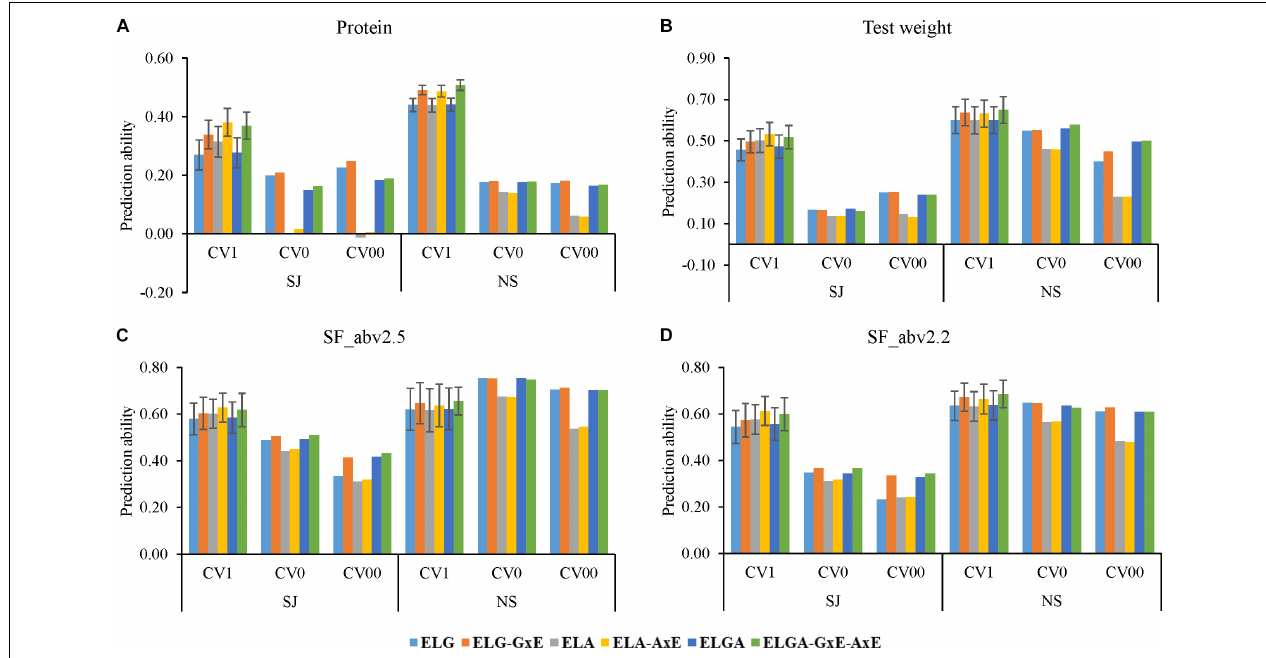
FIGURE 4 | Prediction ability obtained using six models for the three cross-validation schemes in the two breeding programs for all traits. CV1; predicting newly developed lines in known environments, CV0; predicting unknown (future) year, and CV00; predicting newly developed lines in unknown future year prediction abilities for (A) Protein, (B) Test weight, (C) Seed fraction SF_abv2.5, and (D) Seed fraction SF_abv2.2. Error bars depict the standard error from the mean of the 10 fold correlations.